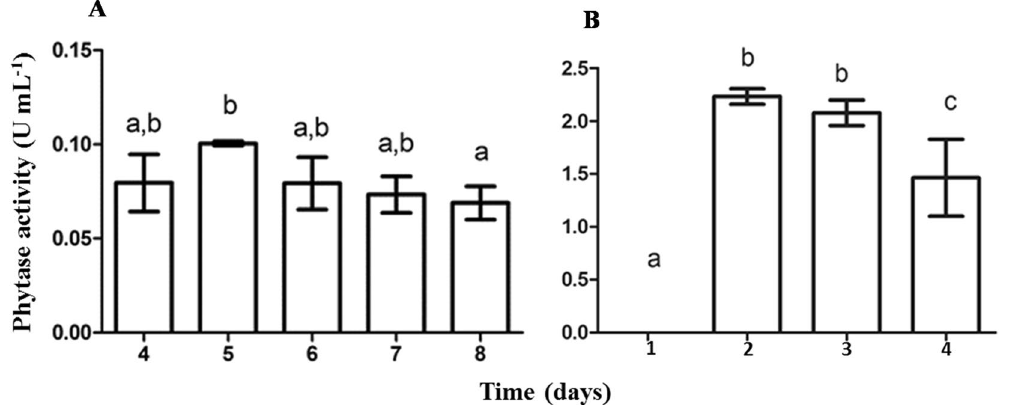
Figure 3. Production of phytase over the incubation time by the fungus Acremonium zeae B ( A ) from corn meal and the yeast Kluyveromyces marxianus ( B ) from rice bran, via solid-state fermentation and submerged fermentation, respectively. The bars correspond to the standard deviations of the means (n = 3). Equal letters do not differ at 95% confidence by the Tukey